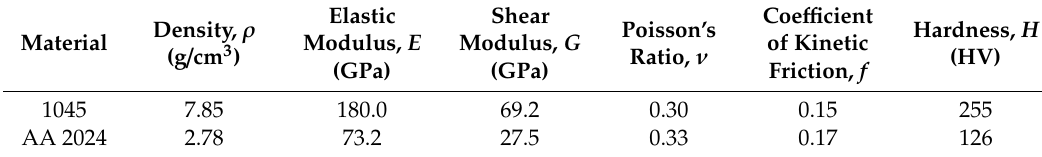
Table 2. Material properties of steel 1045 and aluminum alloy 2024.